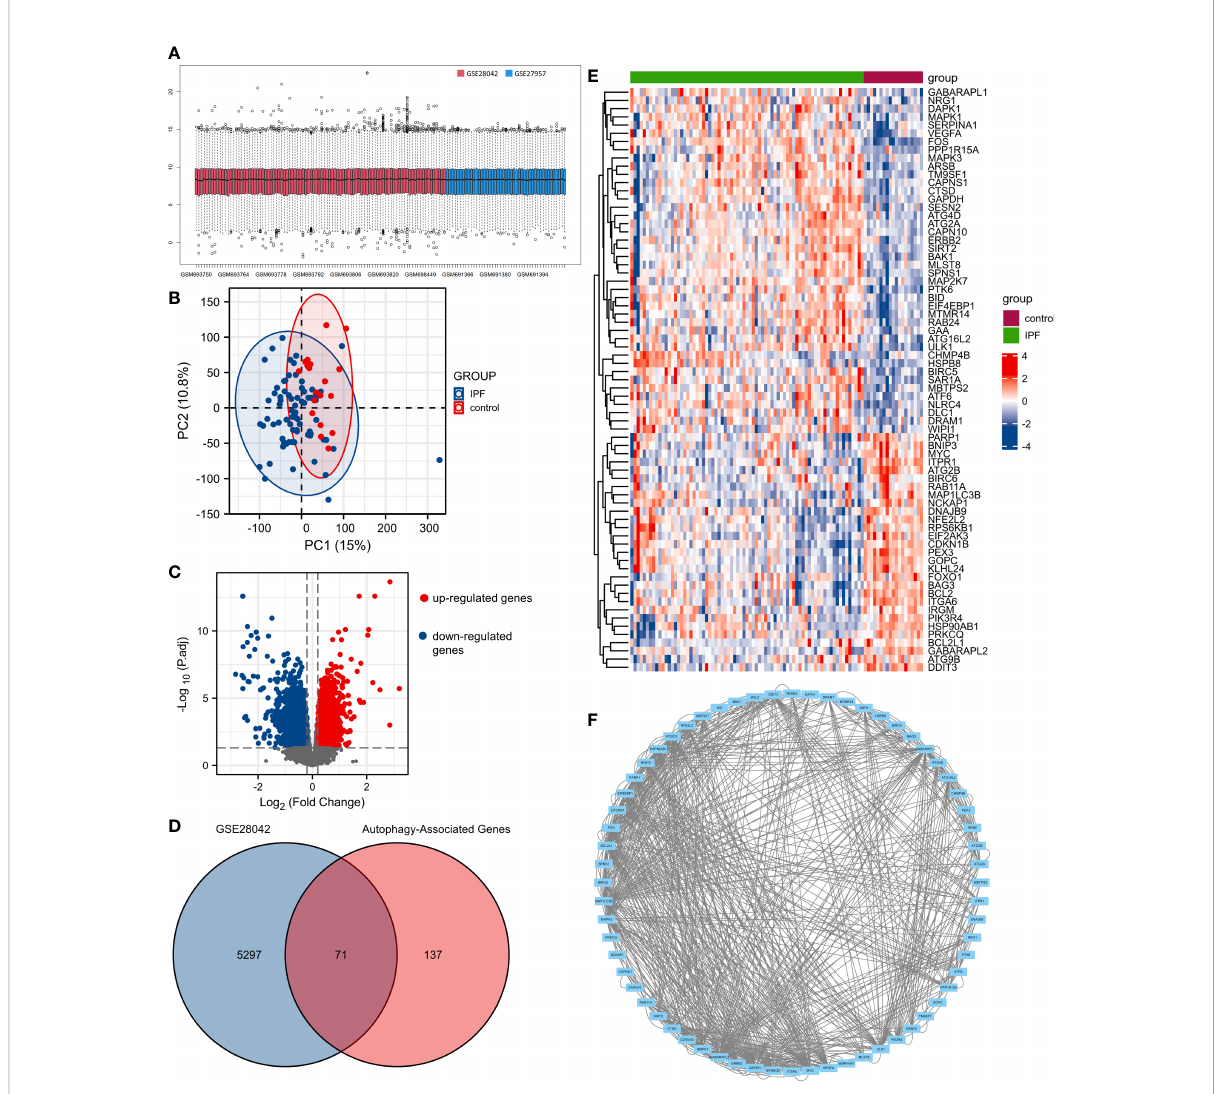
FIGURE 1 The differentially expressed autophagy-associated genes (AAGs) in idiopathic pulmonary fi brosis. (A) Data normalization of GSE28042 and GSE27957. (B) The principal component analysis (PCA) of GSE28042 dataset. (C) Volcano plot of differentially expressed genes in the cohort of GSE28042. (D) Intersection of 5368 differentially expressed genes with 208 autophagy-associated genes. (E) Heatmap of 71 autophagy- associated genes in IPF patients and controls. (F) The PPI network of autophagy-associated